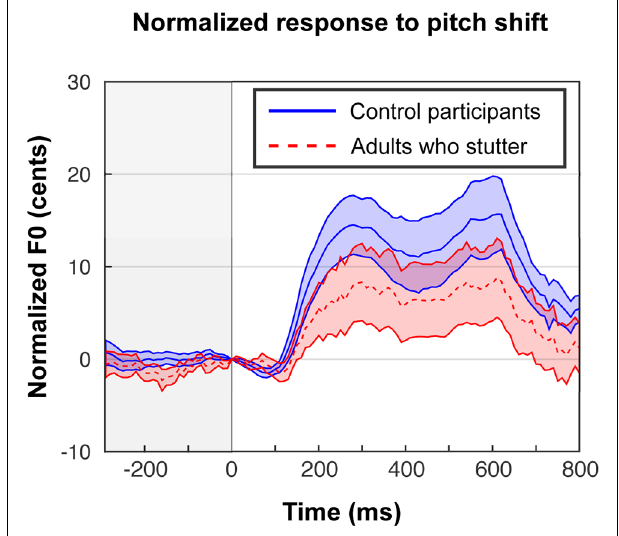
FIGURE 2 | In-scanner behavioral responses to shifted trials in cents, exhibiting a typical compensation effect, although the magnitude of the effect was reduced compared with out-of-scanner responses (Sares et al., 2018). Trials are centered at the moment of the perturbation, and responses to up-shifts are flipped in order to be averaged with down-shifts. Each participant’s shifted trials are normalized by subtracting their characteristic pitch trace in the unshifted trials. Shaded areas show standard error of the